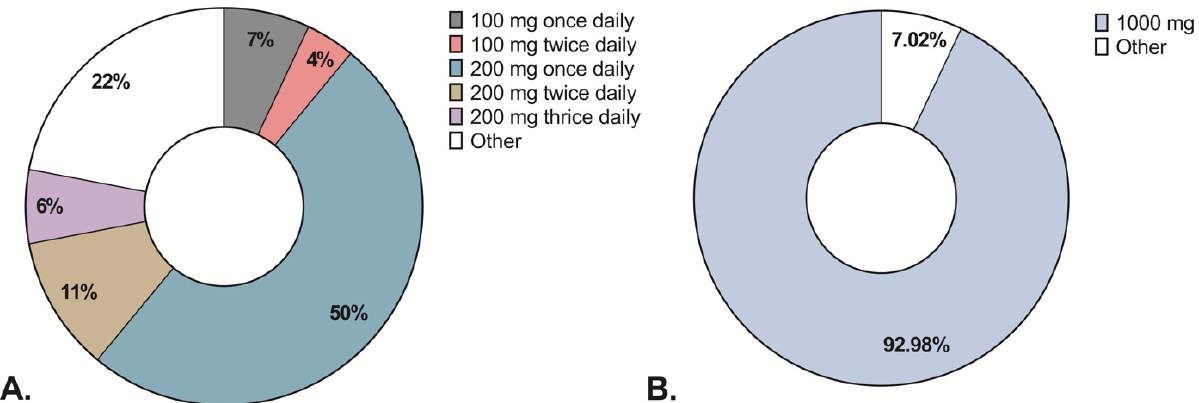
Figure 1. Prescribed oral and intravenous iron dose in patients with Inflammatory Bowel Disease. ( A ) Depicts the prescribed oral iron dosage. ( B ) Depicts prescribed intravenous iron dosage. The represented data are based on patient data extracted from medical records.